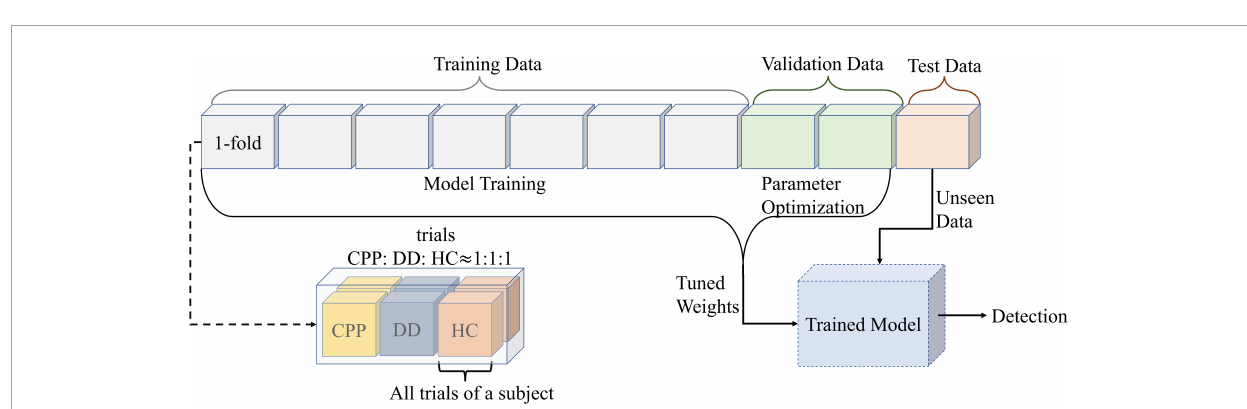
FIGURE4 The data partition diagram used to create the model. Divide all data into 10-folds. The number of trials in each fold is the same, and the number of CPP, DD, and HC are uniform. At the same time, ensure that all data of each subject only exists in onefold. Divide the 10-folds into test set, validation set and training set according to 1:2:7. The training data is used for the training model, and the validation data is used for the parameter optimization. After adjusting the model weights for both sets of data together, the test set is used for